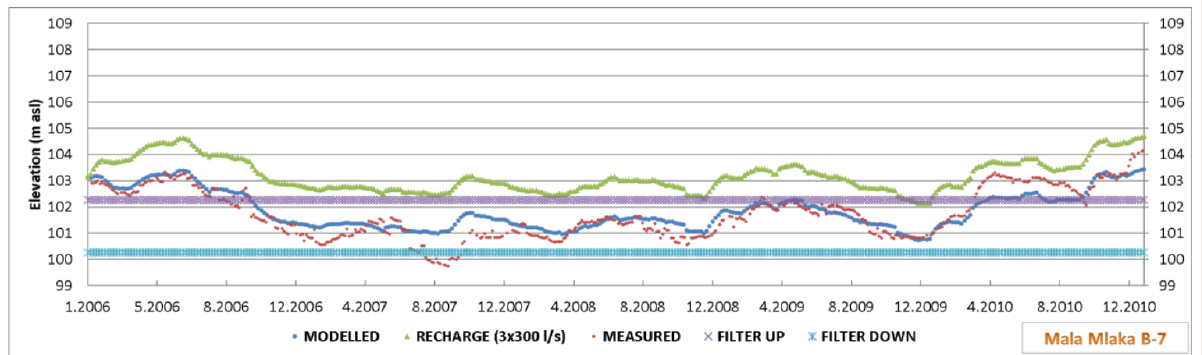
Figure 19. Influence of the MAR with injection wells (3 × 300 L/s) on the exploitation well B-7.